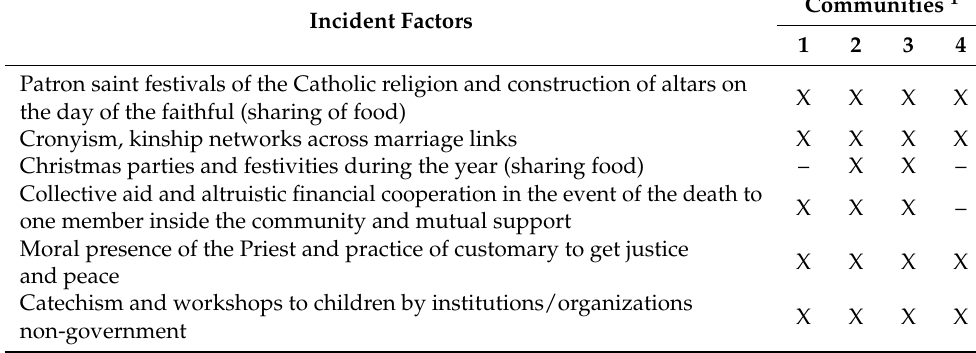
Table 2. Factors that weaken the social cohesion of communities. Incident Factors The existence of socioeconomic levels has given rise to deep poverty and lack of work that forces the people to migrate outside of Puebla (within Mexico) and to the United States to earn money to support their families Economic support and technical training are insufficient and prevent adequate